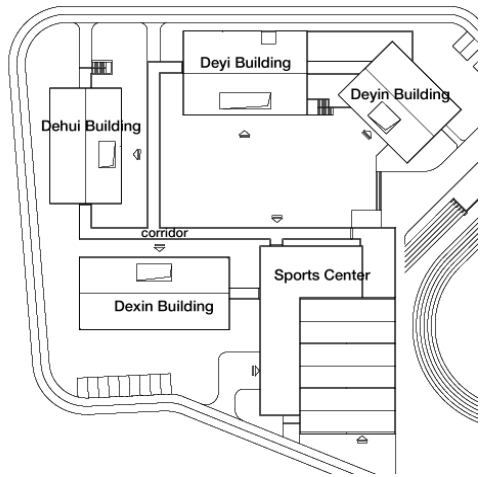
Figure 2. The scale floor plan of the special primary school in Deyang.